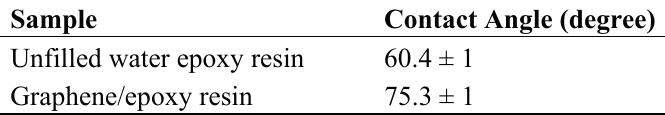
Table 1. Water contact angle values over graphene-filled and unfilled resin.